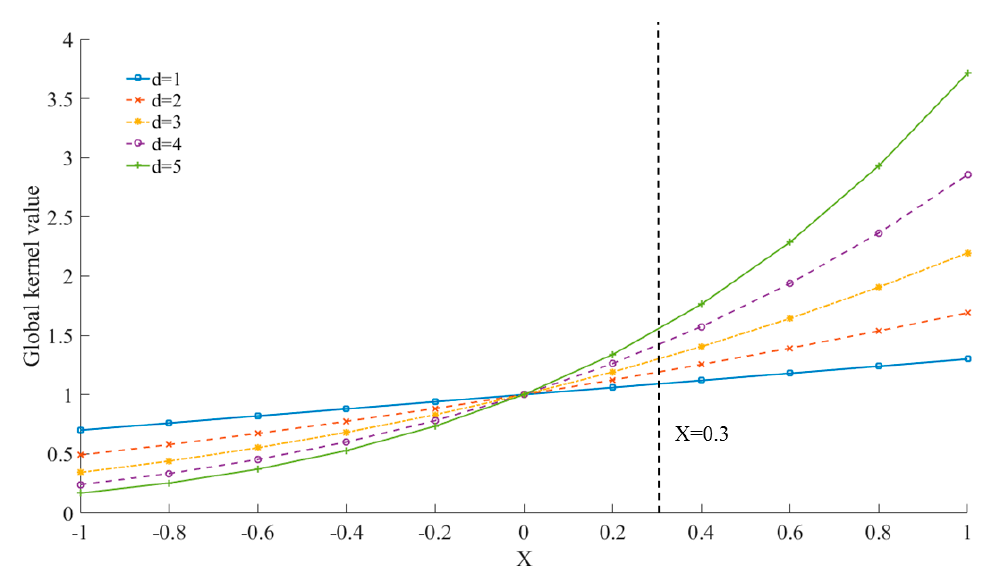
Figure 1. Data distribution of global kernel (polynomial kernel, test point X = 0.3).